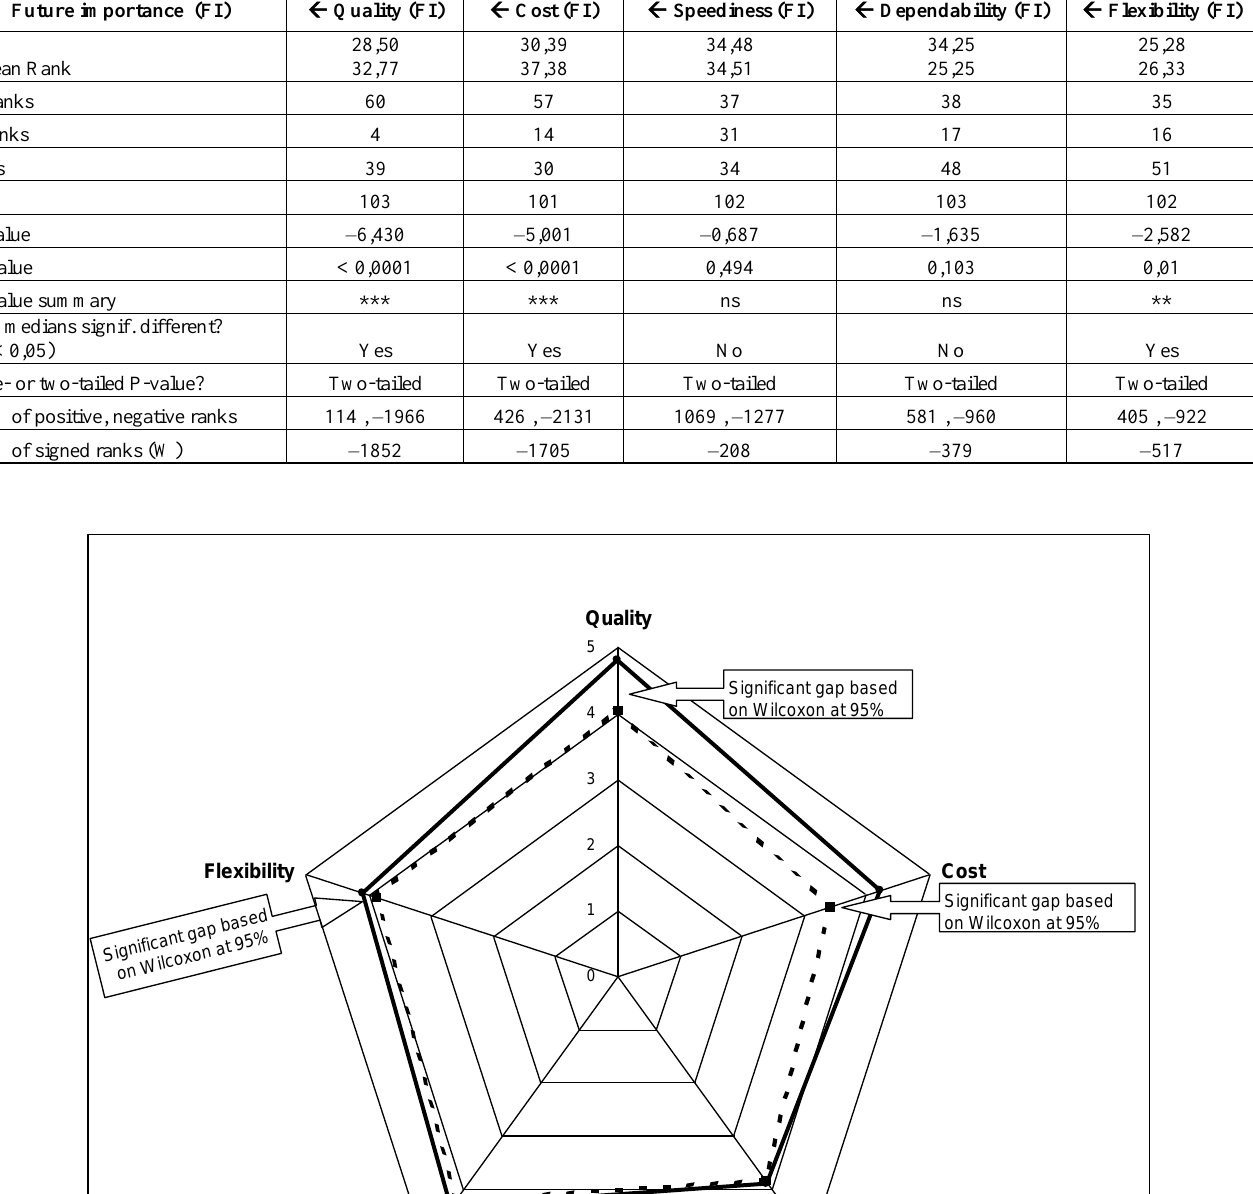
Table 10: Wilcoxon matched-pairs signed ranks rests: movement between decision points: International Current strength (CS) versus Future importance (FI)